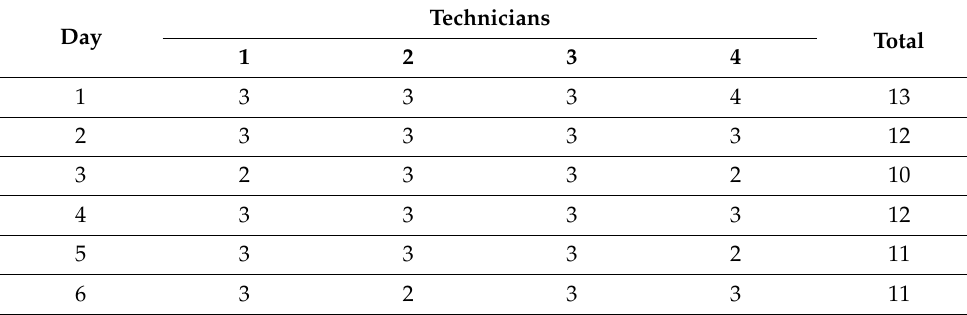
Table 9. The distribution of tasks for technicians in days 1 through 6.